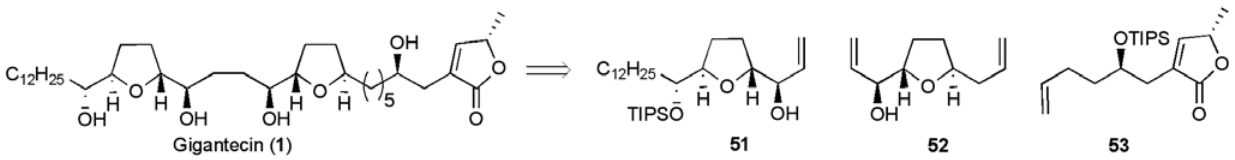
Figure 9. Hoye’s metathesis-based approach to gigantecin ( 1